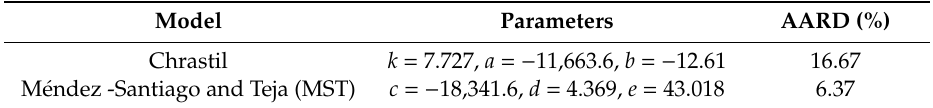
Table 4. Correlation parameters and average absolute relative deviations (AARDs) of the two semi-empirical models (Chrastil model and MST model) to correlate experimental solubility